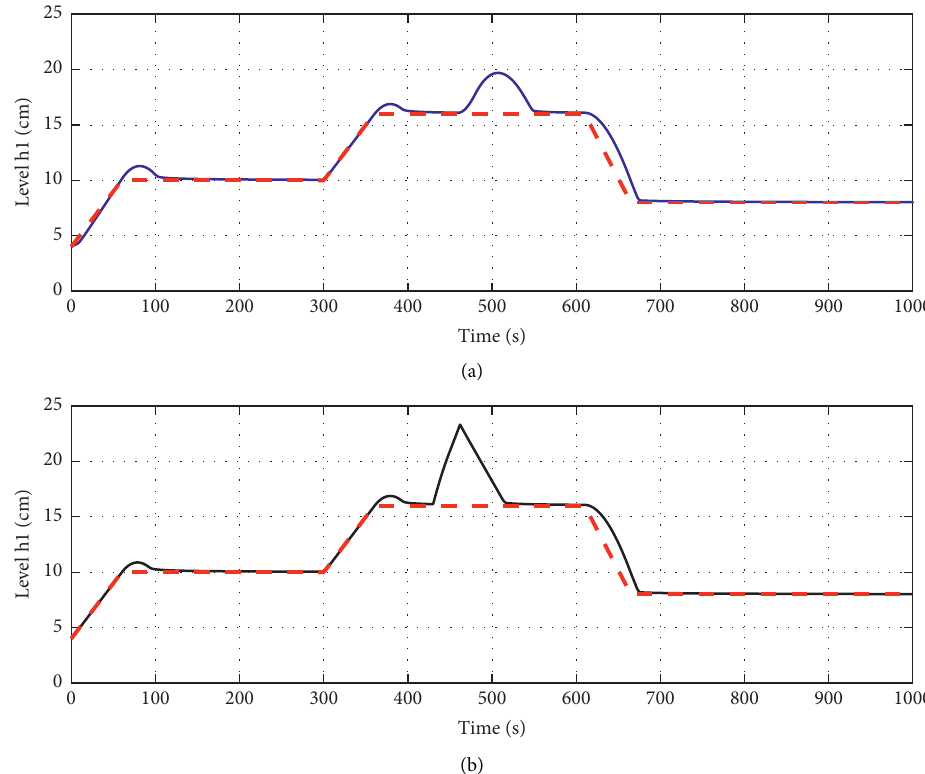
Figure 3: NTSMC tracking result and its impact on disturbances. (a) With impact of the external disturbance; (b) with impact of the parameter